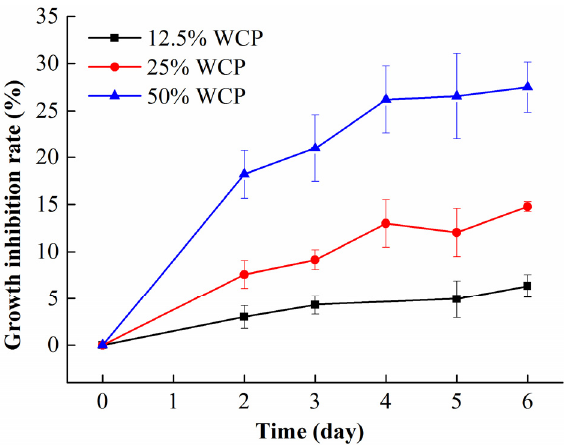
Figure 3. Changes in growth inhibition with cultivation